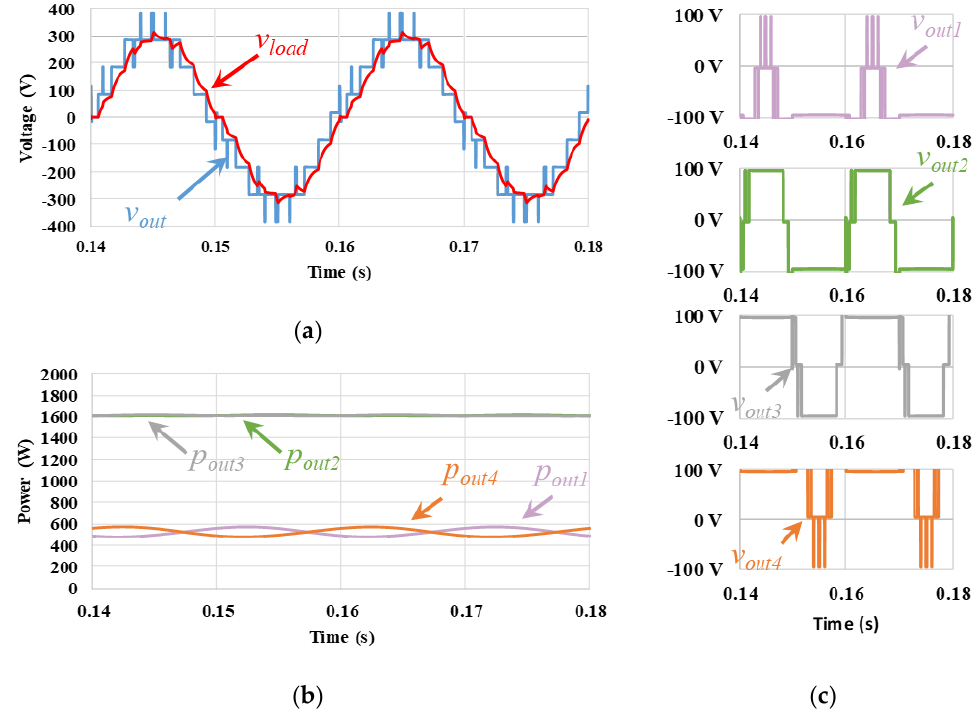
Figure 14. Simulation results of the POD PWM technique: ( a ) output voltage of the cascaded MLC, v out , and load voltage, v load ; ( b ) output power on each submodule ( p out1 , p out2 , p out3 , p out4 ); ( c ) output voltage on each submodule ( v out1 , v out2 , v out3 , v out4 ).